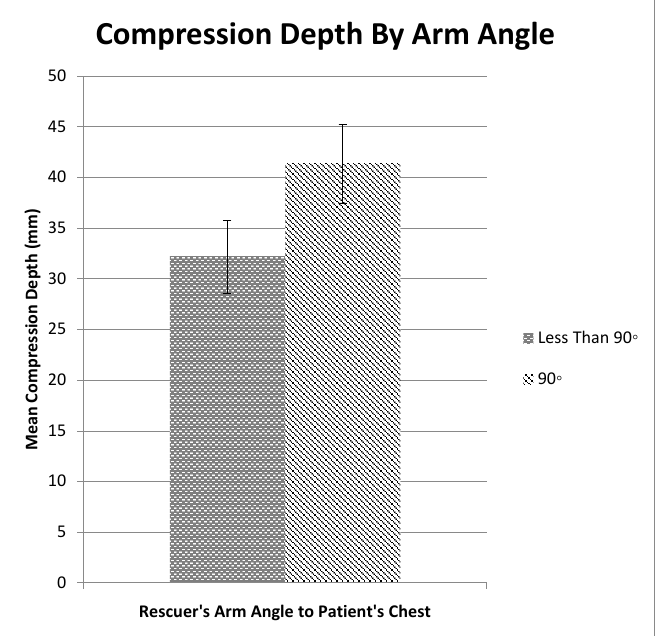
Table. Demographics (gender and height.Gender Figure 3. Distribution of subjects by